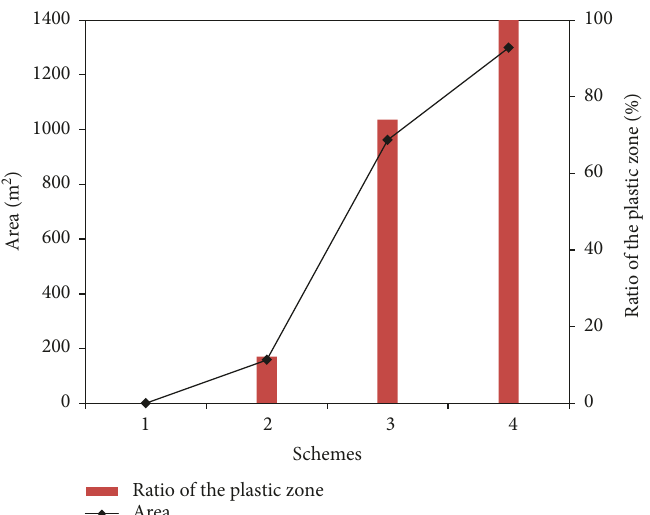
Figure 10: The area of the plastic zone in the potential sliding surface and the ratio of the plastic zone in each